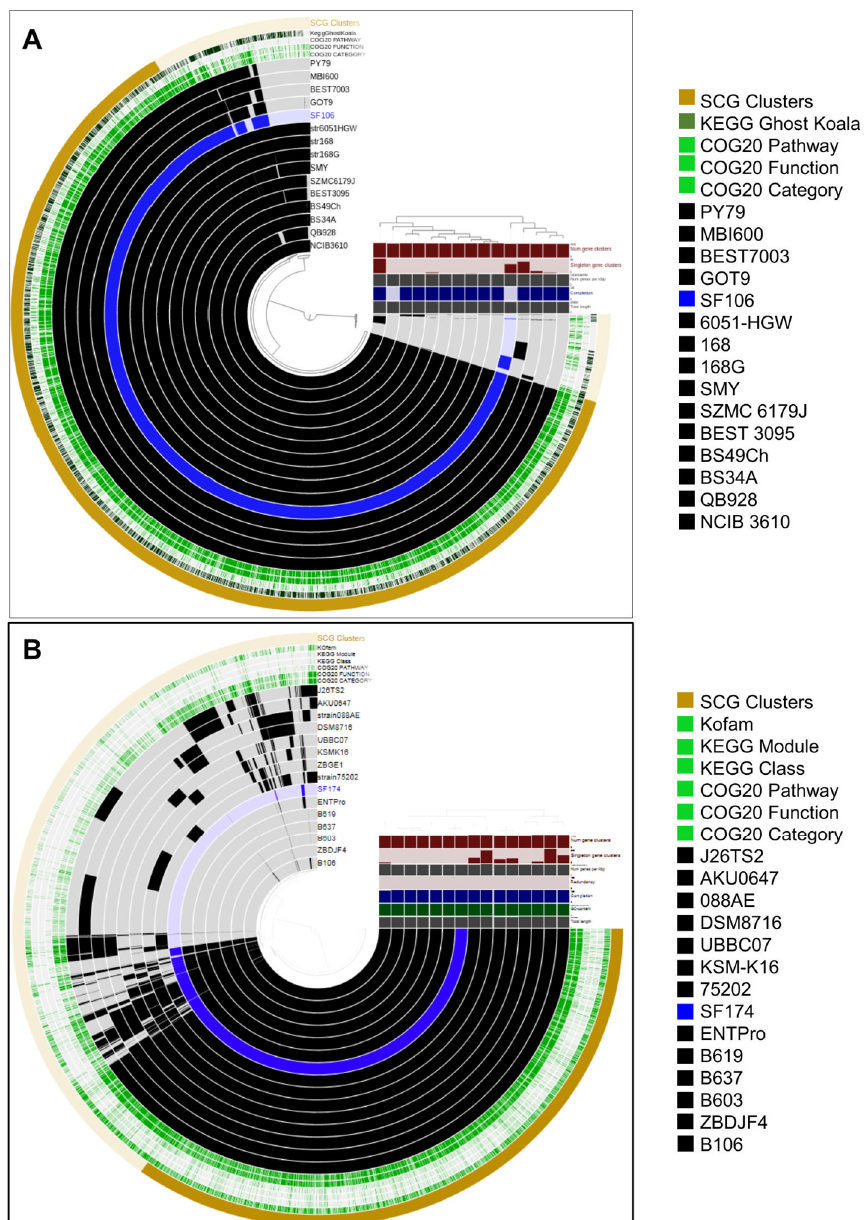
Figure 5. Anvi’o representation of the pangenome of the 15 B. subtilis ( A ) and 15 A. clausii genomes ( B ) generated with the items order in presence/absence (D: Euclidean; L: Ward). Each blue or black layer represents the genome of a strain, in blue SF106 ( A ) and SF174 ( B ) and all others in black. The additional layers indicate the single-copy gene (SCG) clusters (present once in each genome), the KEGG Ghost Koala or Kofam (KEGG Orthology and Links Annotation), KEGG module or class, the COG pathway, function and category.